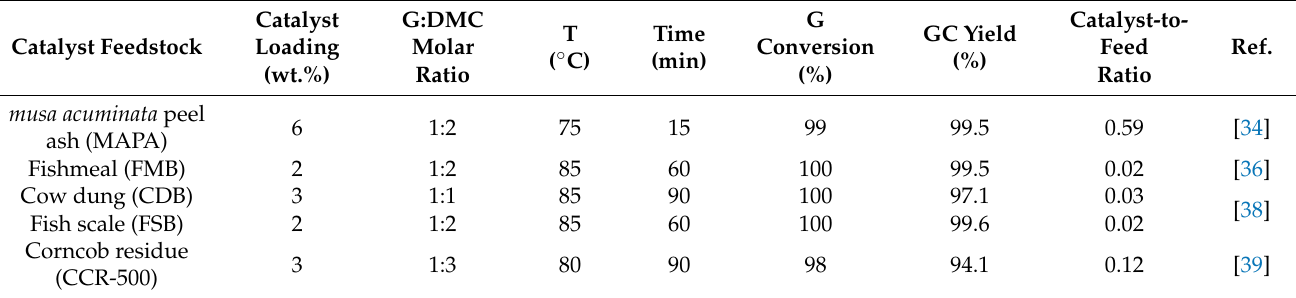
Table 2. Comparison of biochar catalysts performance for the transesterification of glycerol (G) with dimethyl carbonate (DMC) to glycerol carbonate (GC).